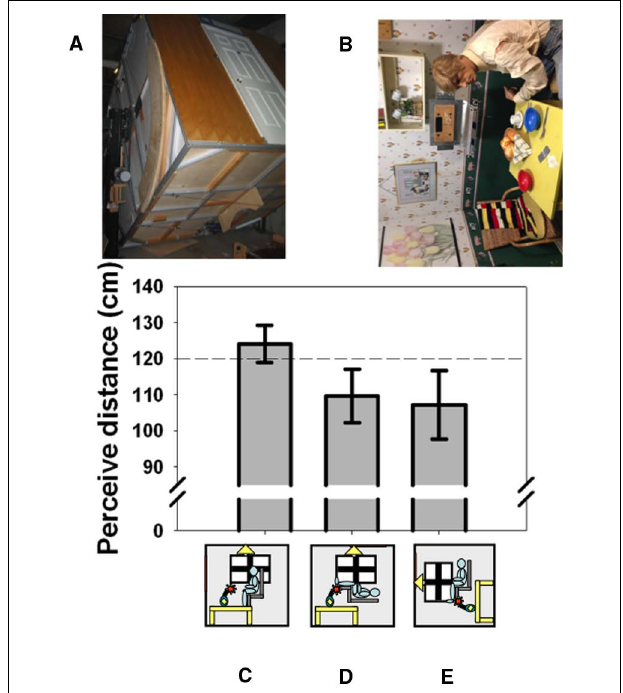
FIGURE 1 | The effect of body orientation on perceived distance. When tested in York University’s Tumbling Room Facility (A,B) , the perceived distance to the wall opposite was obtained from matching the length of a line projected onto the wall with the length of an iron bar that was only felt (C) . The wall was perceived as closer when participants were tilted (D) or felt that they were tilted (E) . The horizontal dashed line indicates the actual viewing distance. (A) shows the room from outside and (B) shows the view seen from inside—the mannequin and all the other objects were glued to the inside of the room. Data reanalyzed from Harris and Mander